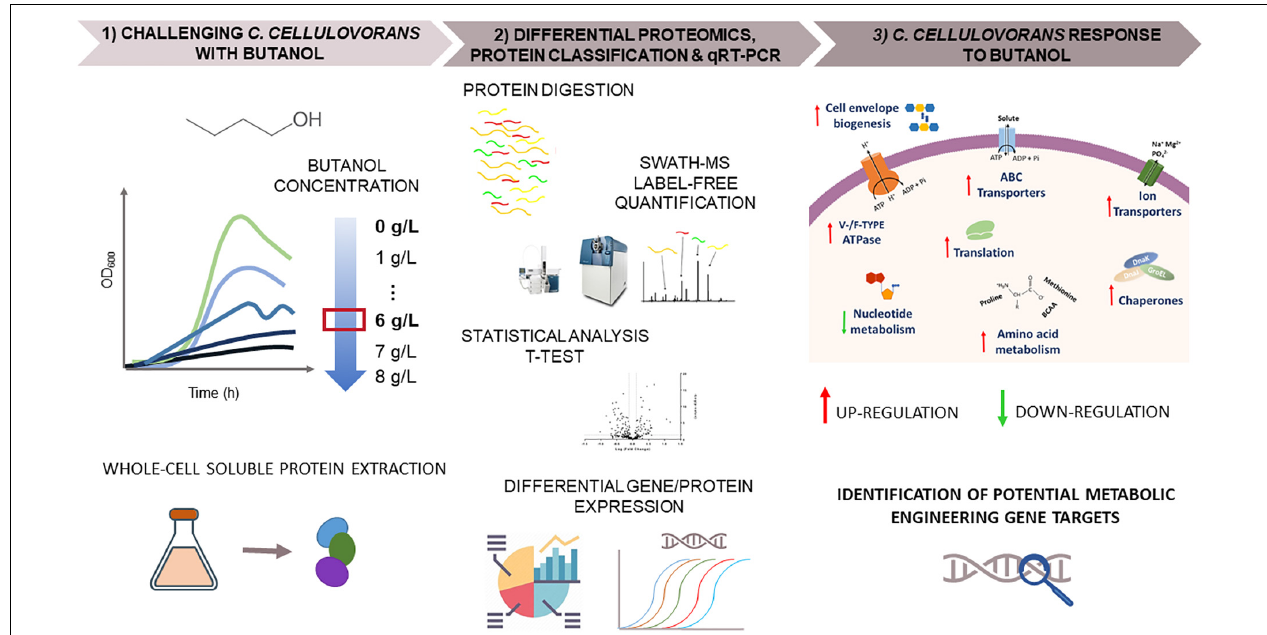
FIGURE 3 | Schematic overview of the proteomic workflow used to study C. cellulovorans responses to butanol stress. (1) C. cellulovorans was grown in media supplemented with different concentrations of butanol (0–8 g/L). Whole-cell soluble protein extraction was performed on C. cellulovorans cells grown in control (0 g/L butanol) or butanol-challenged (6 g/L butanol) cultures. (2) Differential proteomics were analyzed through Sequential Window Acquisition of all Theoretical fragment ion spectra Mass Spectrometry (SWATH-MS). Phylogenetic protein classification by COGs (Clusters of Orthologous Groups of proteins) was performed and qRT-PCR was used to confirm differential gene expression of a gene pool. (3) Butanol-challenged C. cellulovorans metabolism was described by discussing the differentially expressed proteins (up- and down-regulated in butanol-stressed bacteria). This information led to identification of target genes for rational metabolic engineering strategies to obtain a butanol-hypertolerant C. cellulovorans strain for large scale